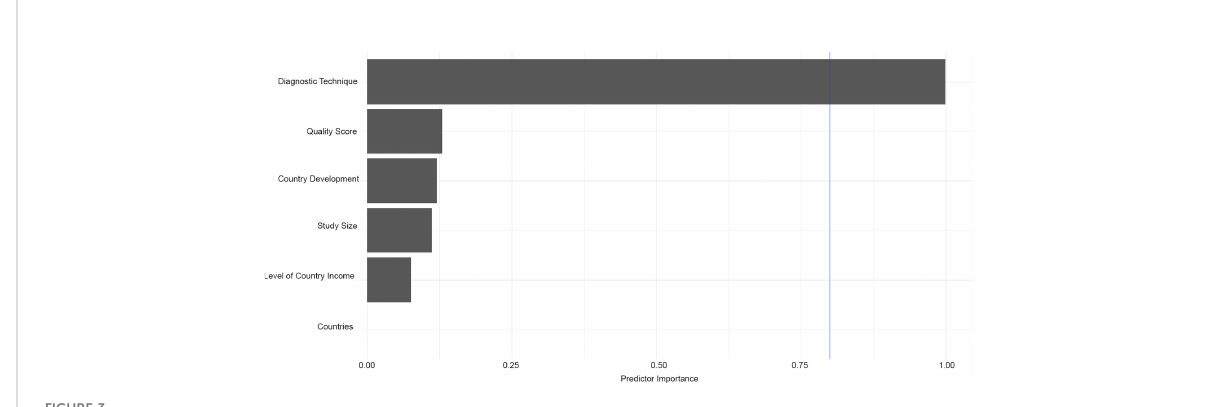
FIGURE 3 Results of multivariable meta-regression